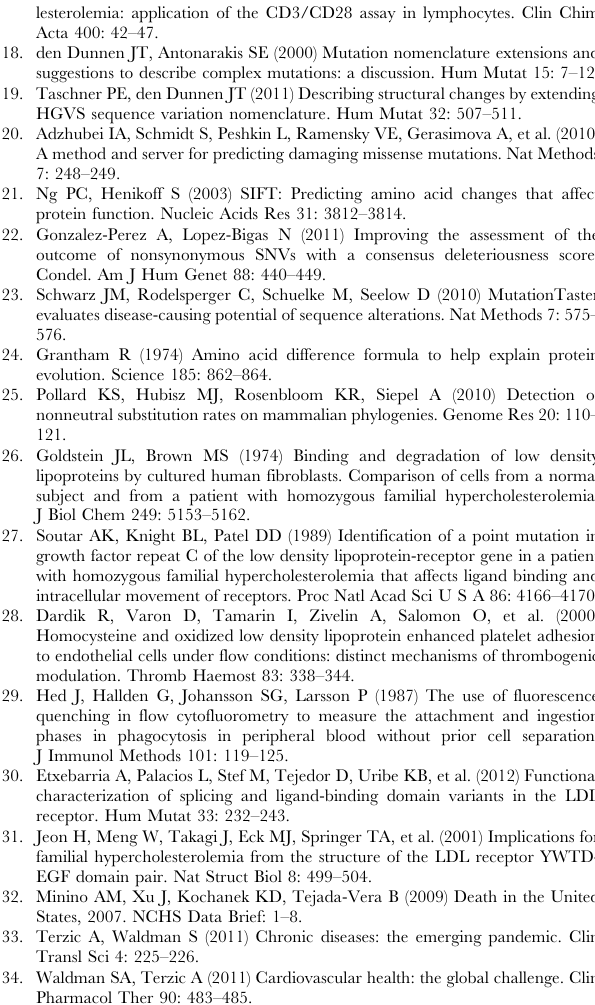
represent the mean of triplicate determinations (n= 3); error bars represent 6 SD. *p , 0.001 compared to LDLR wt using a Student’s t-test. Figure S2 Structure of the blades maintained by the Trp located in the YWTD repeats of the b -propeller. (A) Hydrophobic contacts of the Trp with the surrounding residues, and the water mediated hydrogen bound between the indol group of tryptophan and one carboxylate group of an adjacent Asp maintain the blade-structures. (B) Replacement of Trp490 by an Asn impairs hydrophobic interactions. This figure was prepared with PyMOL (DeLano scientifics) (PDB:1N7D). (TIF) Figure S3 Structure of the Val429 and surrounding amino acids (A). Val429 allows the correct packing of the structure maintaining hydrophobic contacts. Leu429 introduces very little change in size, but maybe sufficient to impair a correct folding of the protein (B). This figure was prepared with PyMOL (DeLano scientifics) (PDB:1IJQ). (TIF) Figure S4 Structure of the b -propeller central barrel (A). The prolines located at the beginning of each b -sheet allow a